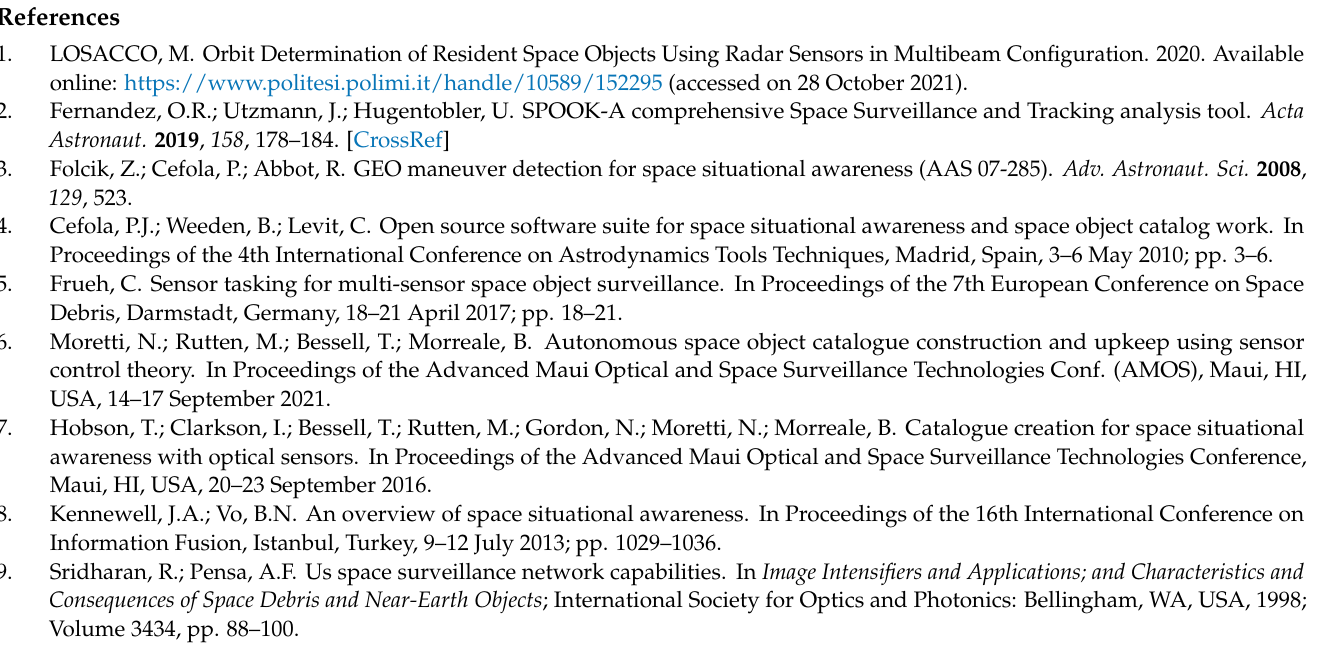
the maneuvers. Figure S2: Baseline Case, Vertical green line represents the maneuvers and the red circle represents potential maneuvers detected from this method. Figure S3: Case 1: Increase in maneuver detection threshold, Vertical green line represents the maneuvers and the red circle represents potential maneuvers detected from this method. Figure S4: Case 2: Decrease in maneuver detection threshold, Vertical green line represents the maneuvers and the red circle represents potential maneuvers detected from this method. Figure S5: Case 3: Window decreased by a factor of three relative to baseline case with detection limit 0.5-sigma, Vertical green line represents the maneuvers and the red circle represents potential maneuvers detected from this method. Figure S6: Case 4: Window increased by a factor of four relative to baseline case with detection limit 0.5-sigma, Vertical green line represents the maneuvers and the red circle represents potential maneuvers detected from this